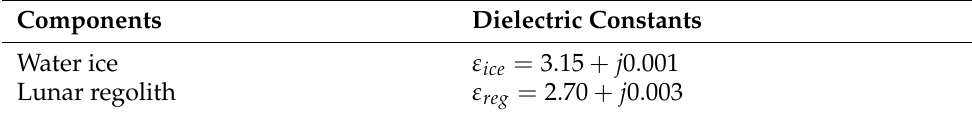
Table 1. The dielectric constants of the water ice and lunar regolith on the Moon [15].